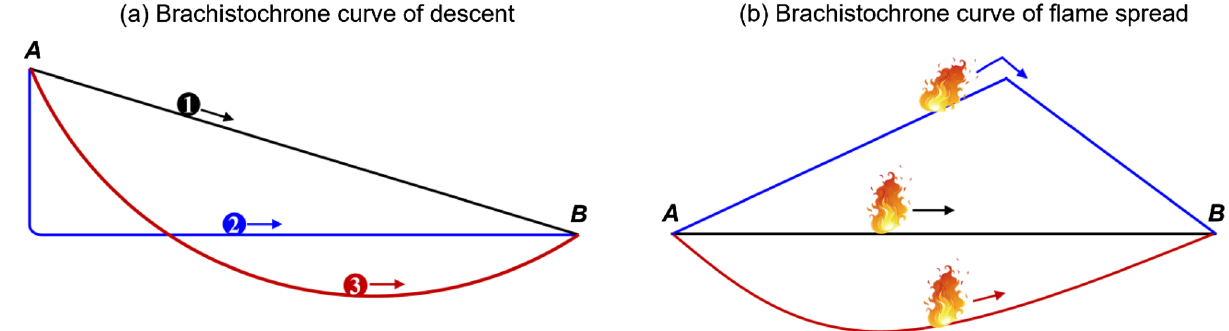
Figure 1. ( a ) The conventional Brachistochrone curve and ( b ) the Brachistochrone curve in fire spread.